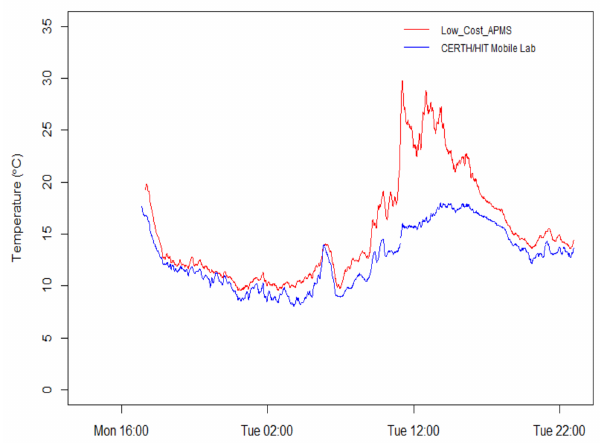
Figure 5. Time series of temperature measurements with 1 min resolution.